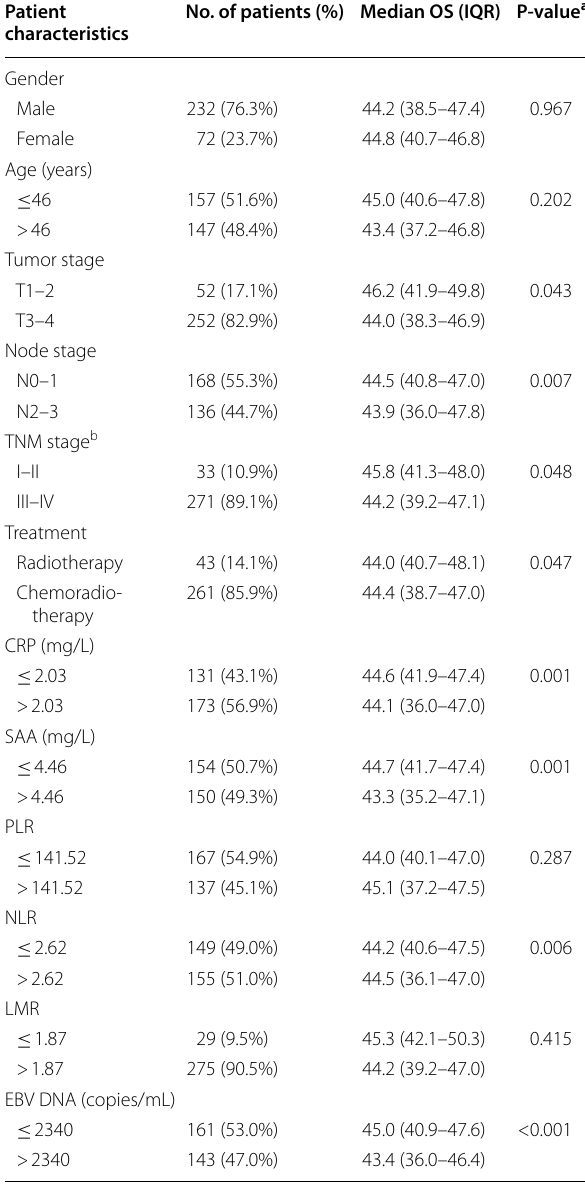
Table 1 Clinical and laboratory characteristics of